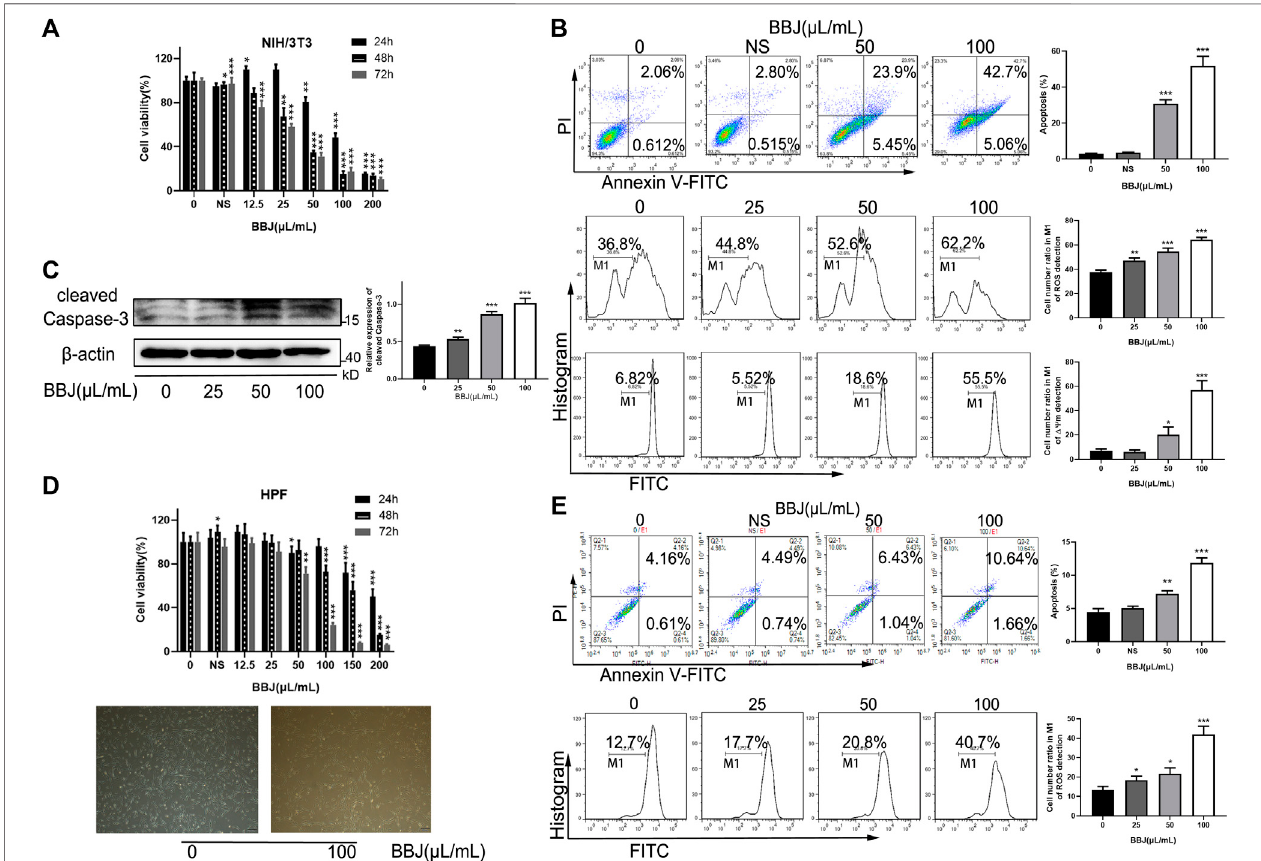
FIGURE 1 | BBJ induced apoptosis in NIH/3T3 and HPF. (A) NIH/3T3 was treated with BBJ or NS for 24, 48, and 72 h. The cell viability was disclosed by MTT assay. (B) Apoptoticrate,ROS,and ΔΨ mofNIH/3T3treatedwithBBJfor24 hwereanalyzedandexpressedasbarhistograms. (C) Expressionofcleavedcaspase-3in NIH/3T3 was detected through a western blot assay and calculated by ImageJ after incubation with BBJ for 24 h. (D) Under treatment with various doses of BBJ for 24 h, the viability of HPF was determined by MTT tests, and cell morphology was observed. (E) HPF was dealt with BBJ for 24 h, and apoptosis and ROS were analyzed by fl ow cytometry. * p < 0.05; ** p < 0.01; *** p < 0.001 compared with the control